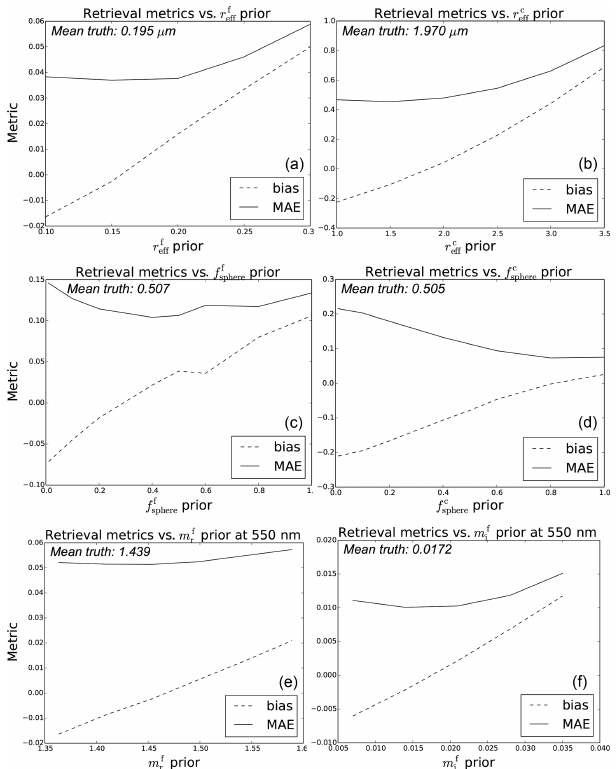
Figure 3. Retrieval metrics as a function of prior, for the HSRL-2 setup with noise. (a, b) Results for fine- and coarse-mode effective radius, with the prior in micrometres (µm). (c, d) Results for fine- and coarse-mode spherical fraction. (e, f) Results for the fine-mode component of the real refractive index on the left and results for the imaginary component of the fine-mode refractive index on the right. Each plot shows bias and